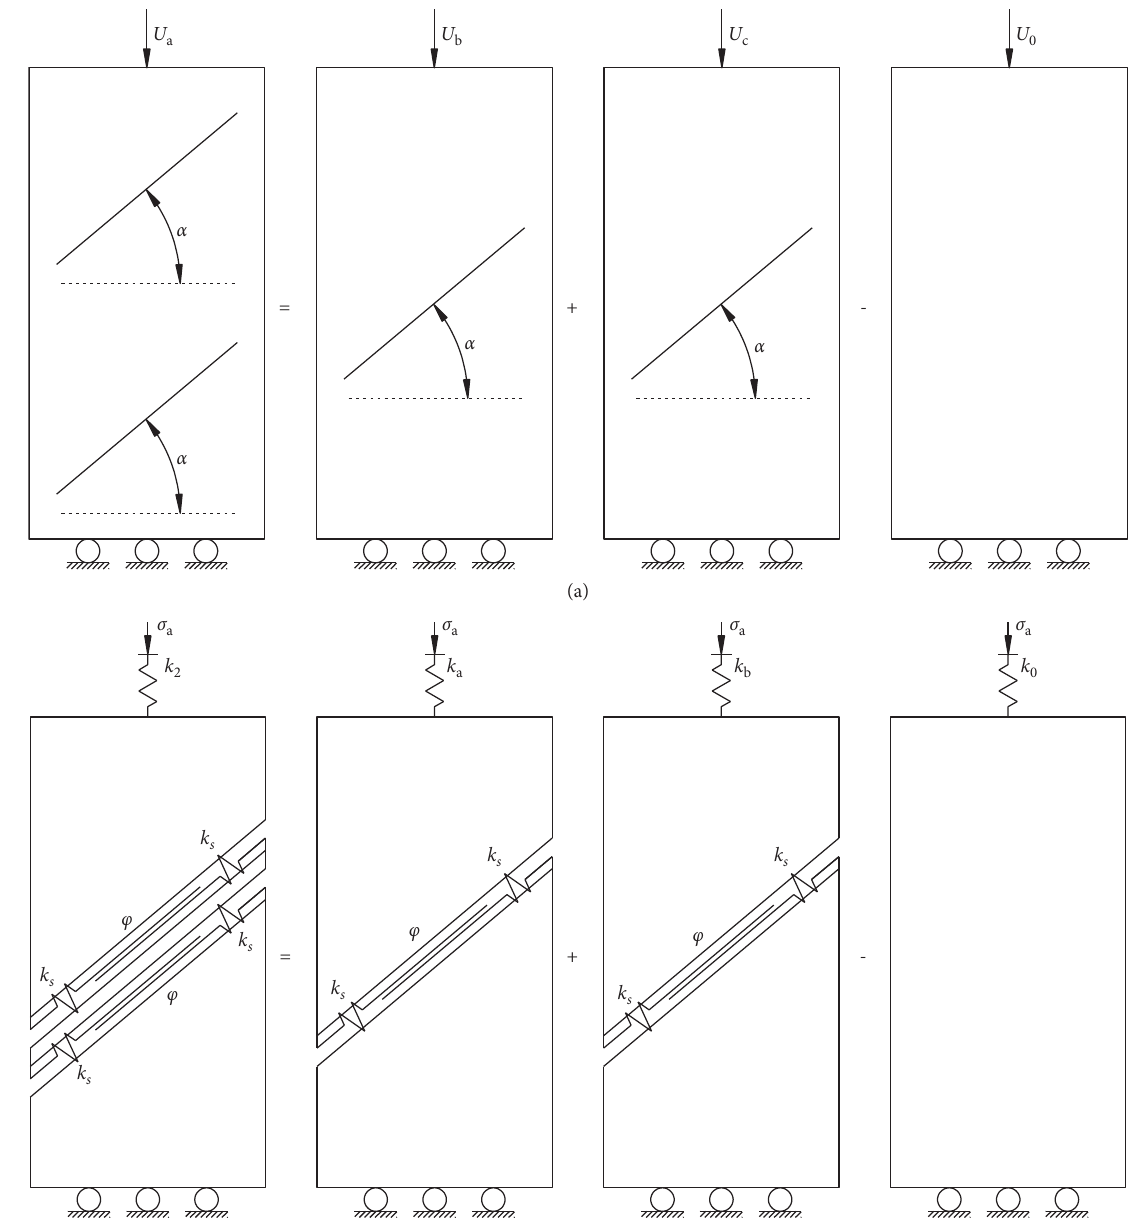
Figure 5: Model of coal body containing two joints. (a) Combined models for coal containing two joints. (b) The equivalent physical combined